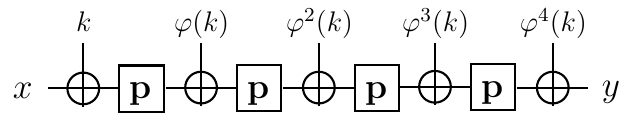
Figure 1: The minimal construction EMSP[ φ ] p p : { 0 , 1 } n → { 0 , 1 } n and an affine key schedule permutation φ : { 0 , 1 } n → { 0 , 1 } n . One can set φ to be a linear orthomorphism, or φ ( k ) := k ≫ Table 1: Comparison of our result with existing seq-indifferentiable IEM results. The column Key sch. indicates the key schedule functions in the schemes. The column Complex. indicates the simulator complexities. For EMSP[ φ ] p orthomorphism φ , and C ( φ ) = 2 a for φ ( k ) = k ≫ Scheme ♯ Rounds ♯ Primitives Key sch. Complex. Bounds